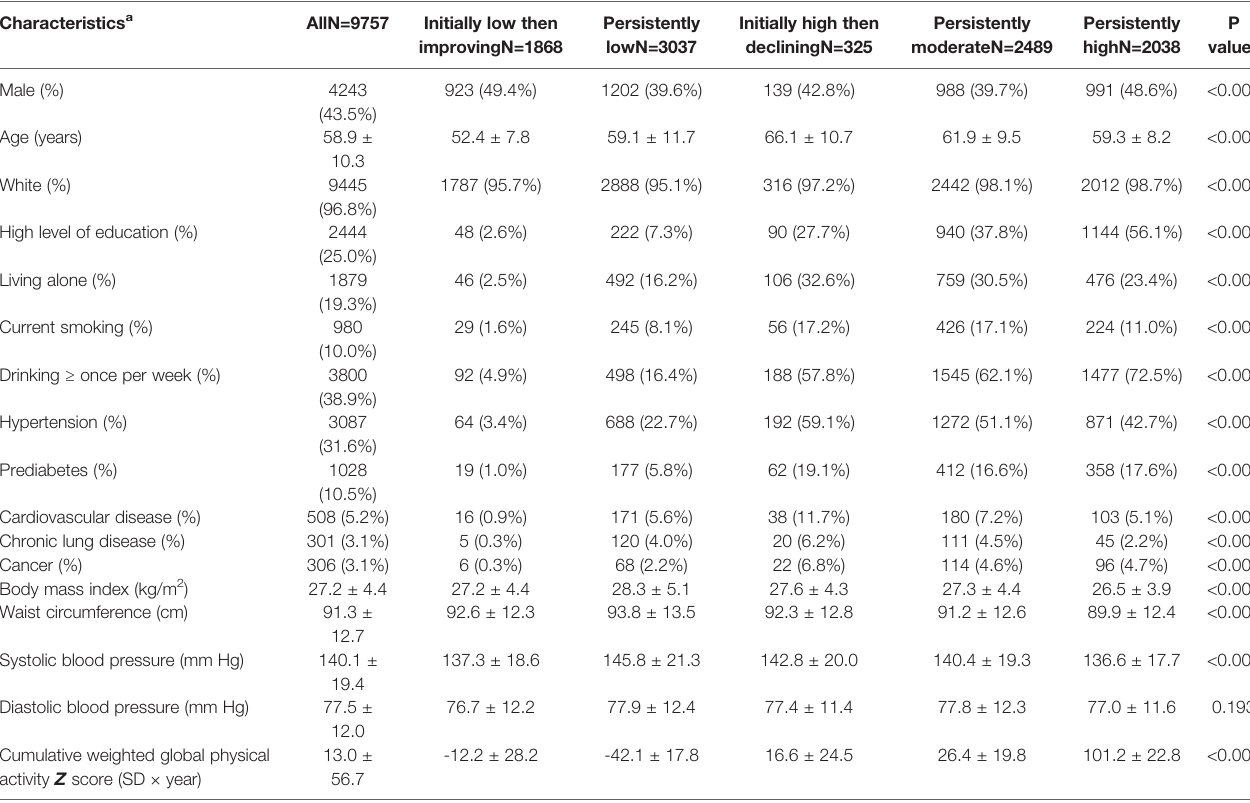
TABLE 1 | Baseline characteristics of study population according to physical activity trajectories.